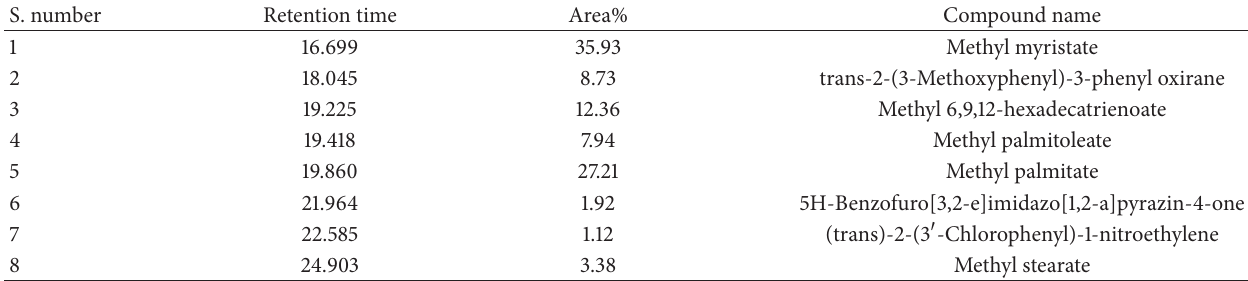
Table 2: Fatty acid profile of pure n-hexane extract.